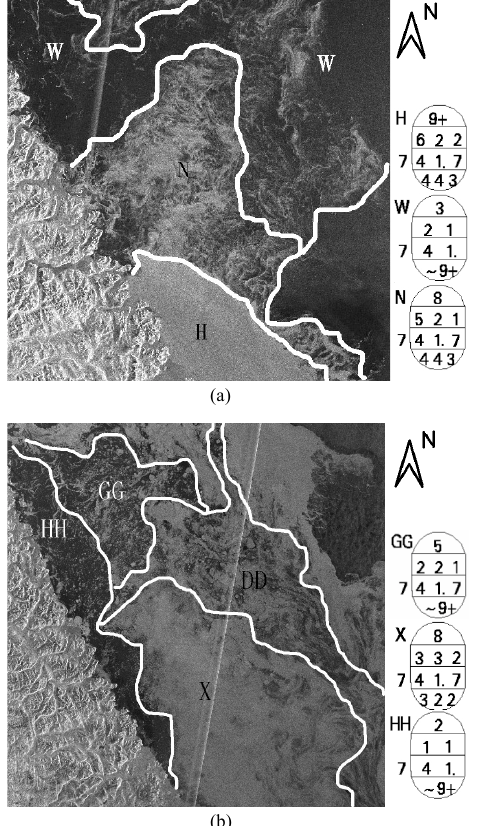
Fig.8 RADARSAT-1 SAR image of part of Hudson Bay for (a) May 12 and (b) May 26. Images are superposed with borderlines of ice chart polygons taken from Canadian Ice Service for the same day. Letters in the polygons denote the regions investigated further with the corresponding egg code given to the right of each image.